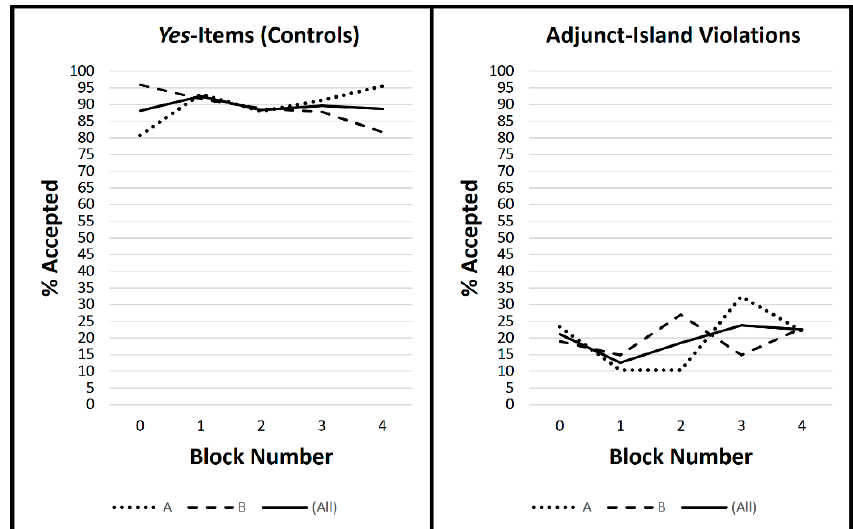
Figure 9. Experiment III, Yes -items and Adjunct-Island violations.